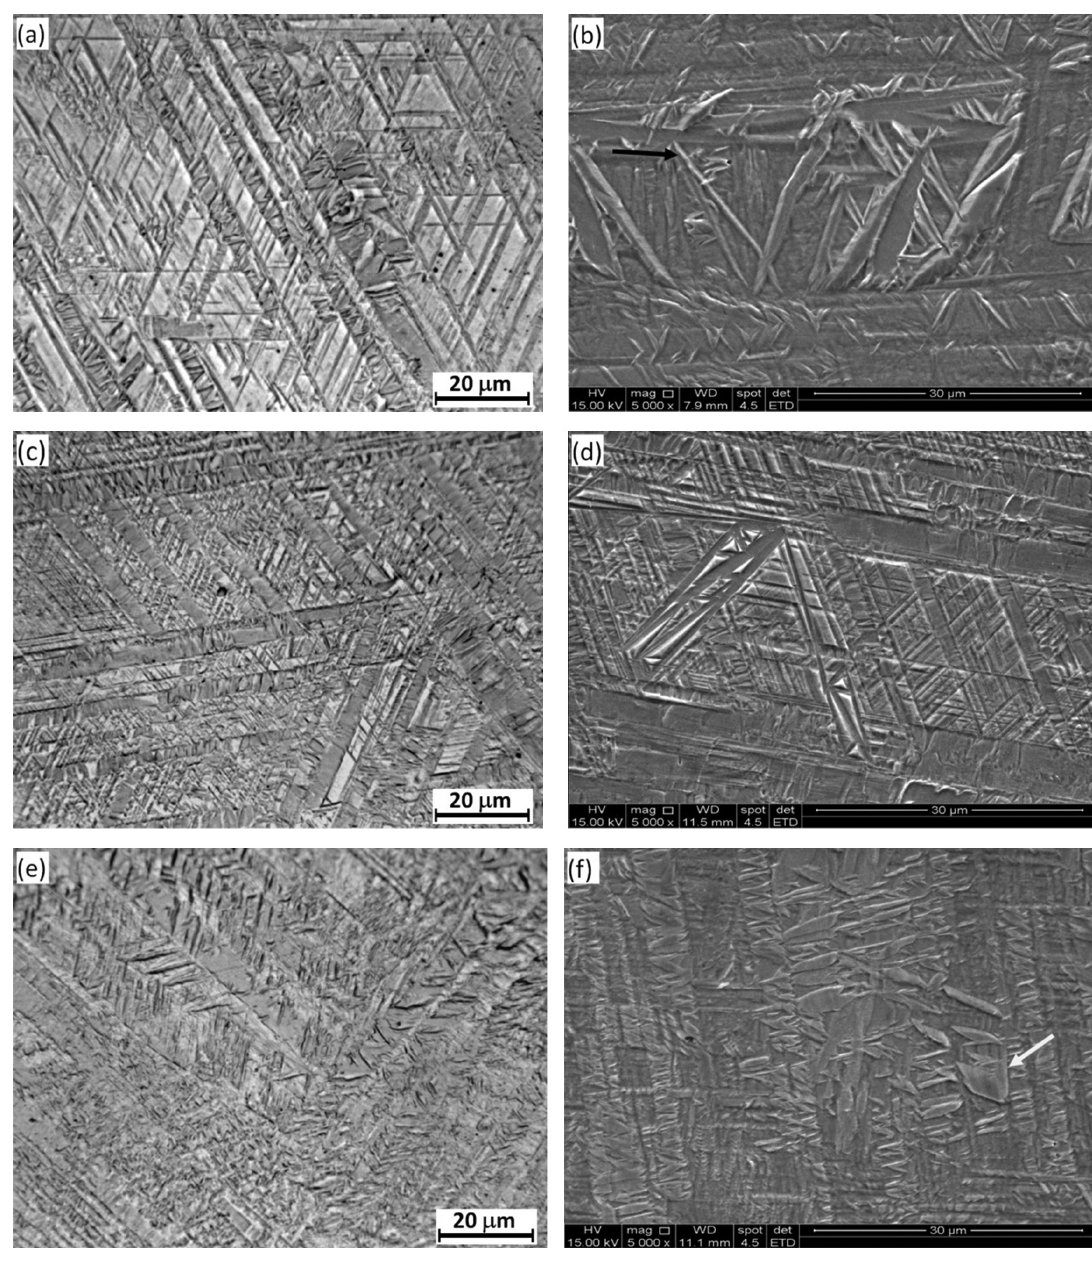
Figure 4. Optical (left) and scanning electron (right) micrographs of the samples (a, b) furnace cooled, (c, d) air cooled, and (e, f) water quenched. Samples were etched with 4%